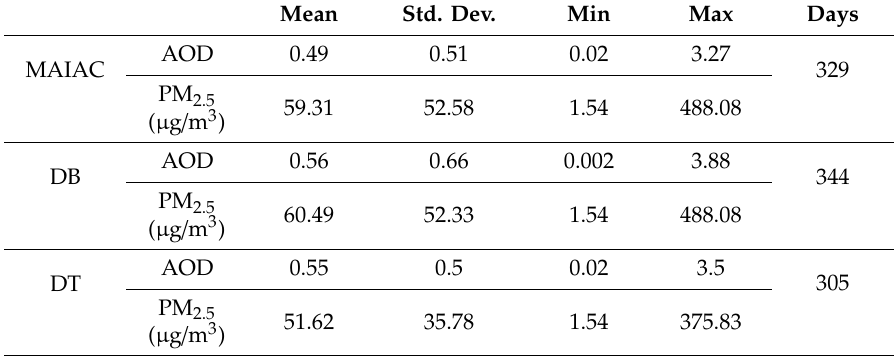
Table 2. Descriptive statistics of variables. The term Days here denotes the number of days with available AOD-PM 2.5 matchups.